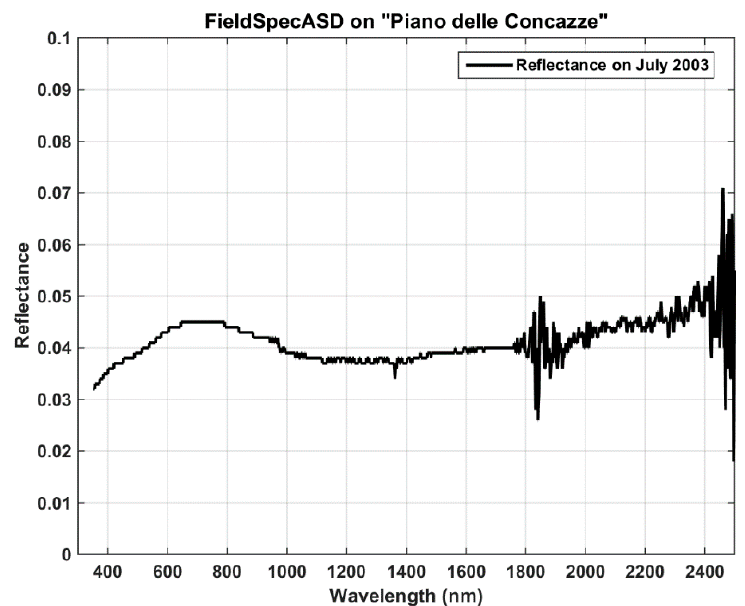
Figure 4. FieldSpec spectrum collected at ‘PdC’ during the July 2003 campaign.